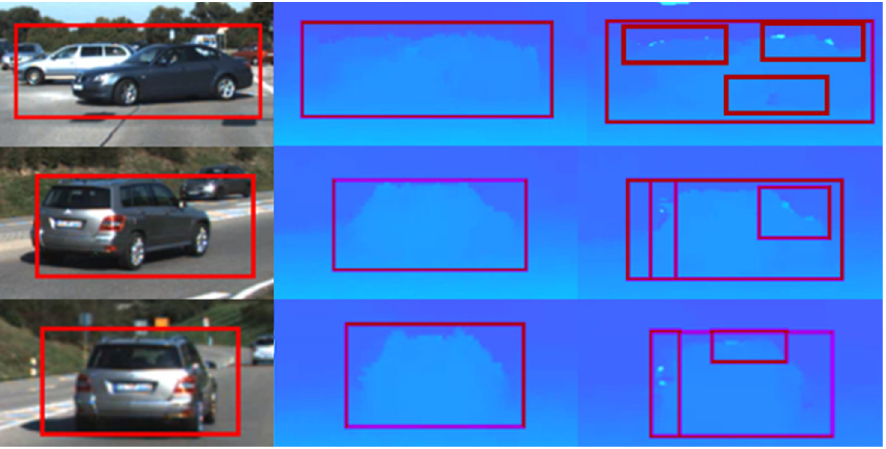
Figure 5. Noise comparison in the disparity map: ( left ) original images, ( center ) depth map images obtained using the proposed algorithm, ( right ) depth map images obtained using Luo et al.’s algorithm with (37 × 37) configuration.